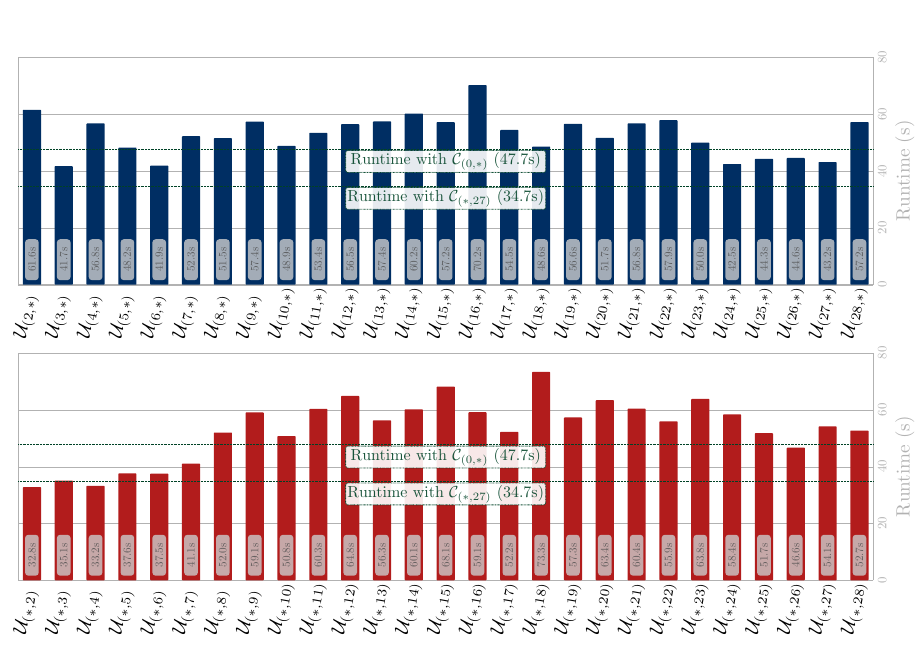
and U for GIFT-64 ( r, ∗ ) ( ∗ ,r )